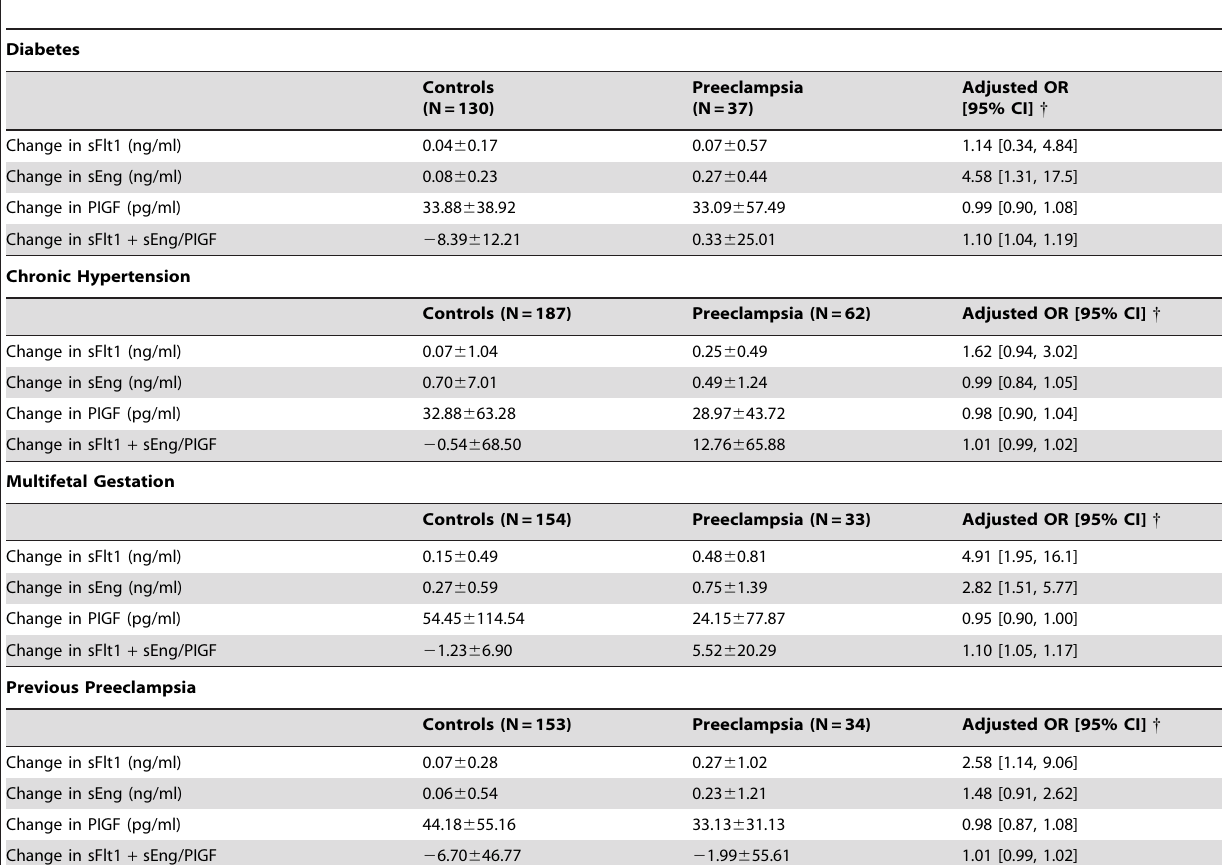
Table 3. Odds Ratios for Preeclampsia According to the Change per Week in Circulating Angiogenic Factors between Study Entry and Second Study